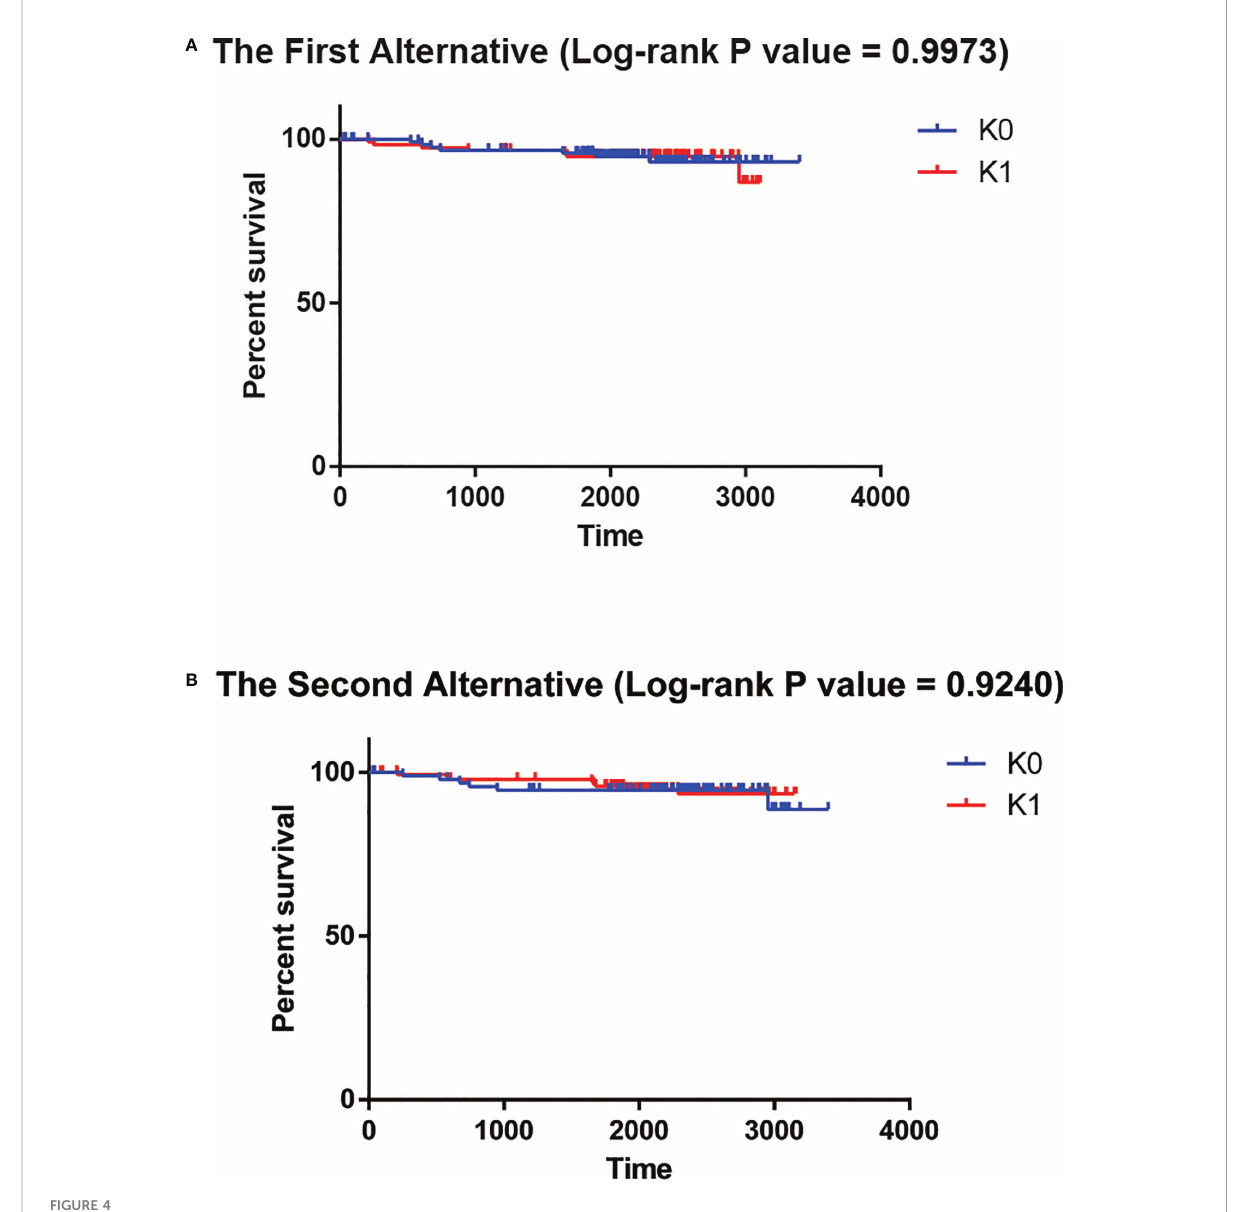
CIBERSORT algorithm analysis (P< 0.05, Figure 6C). The K0 group was signi fi cantly enriched in T cells CD4 naive and T cells gamma delta (P< 0.05, Figure